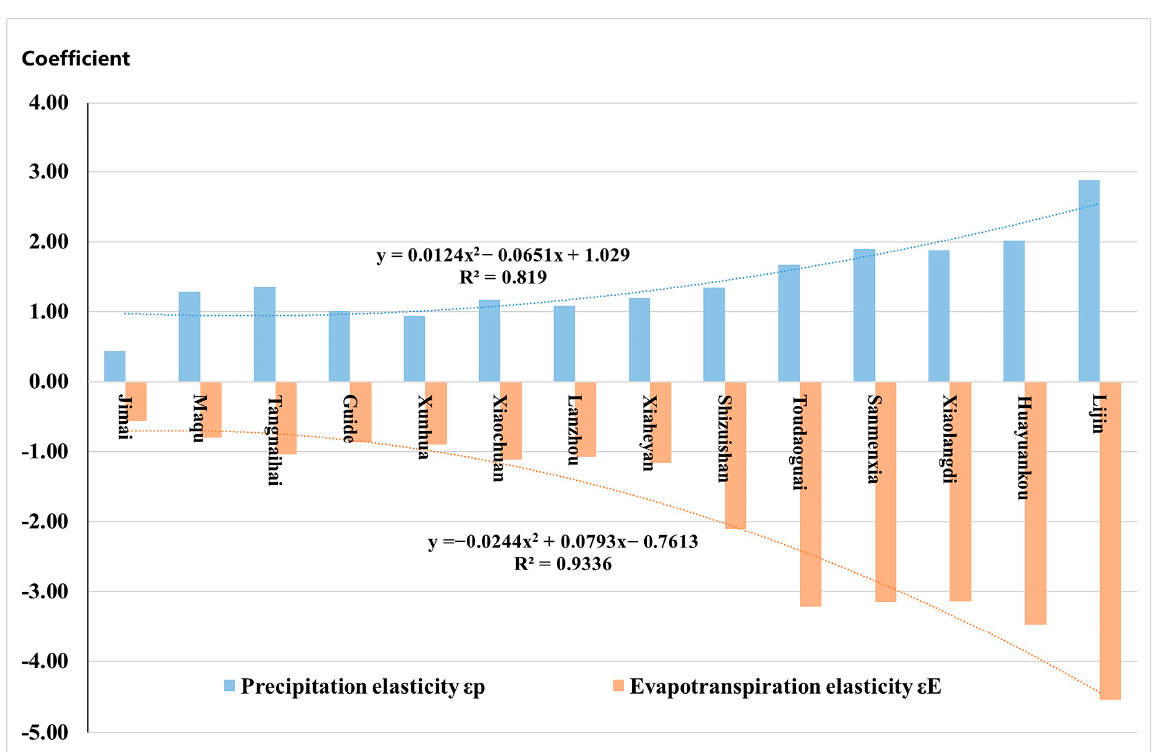
Figure 5. Elastic coefficient of precipitation and potential evapotranspiration at the control section of the mainstream of the Yellow River Basin.